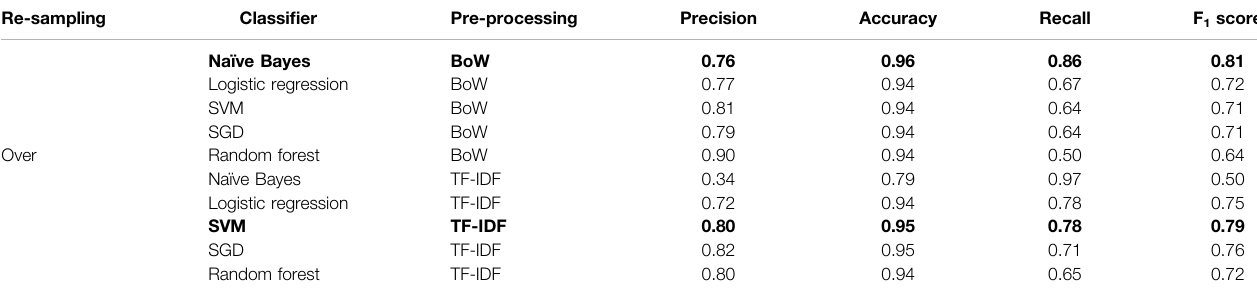
TABLE5| Evaluationmetrics(precision,accuracy,recall,andF 1 score)foralltheclassi fi ersafterURLfeatureselection.Boldvaluesrepresentthehighestperformanceresults based on the F 1 score. As shown in this table, the naïve Bayes classi fi er performed better with F 1 score 0.81 compared to other classi fi ers using BoW in case of